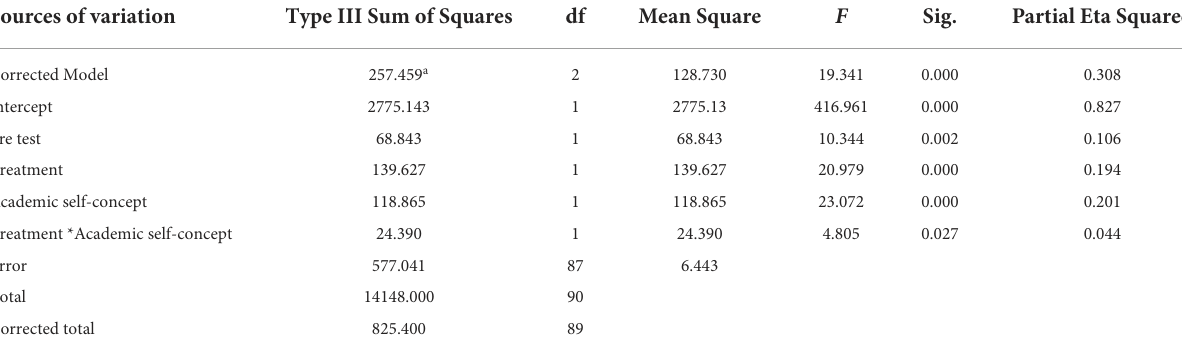
TABLE 7 A summary of 2 × 2 analysis of covariance of influence of treatment and academic self-concept on the academic performance of chemistry students. Sources of